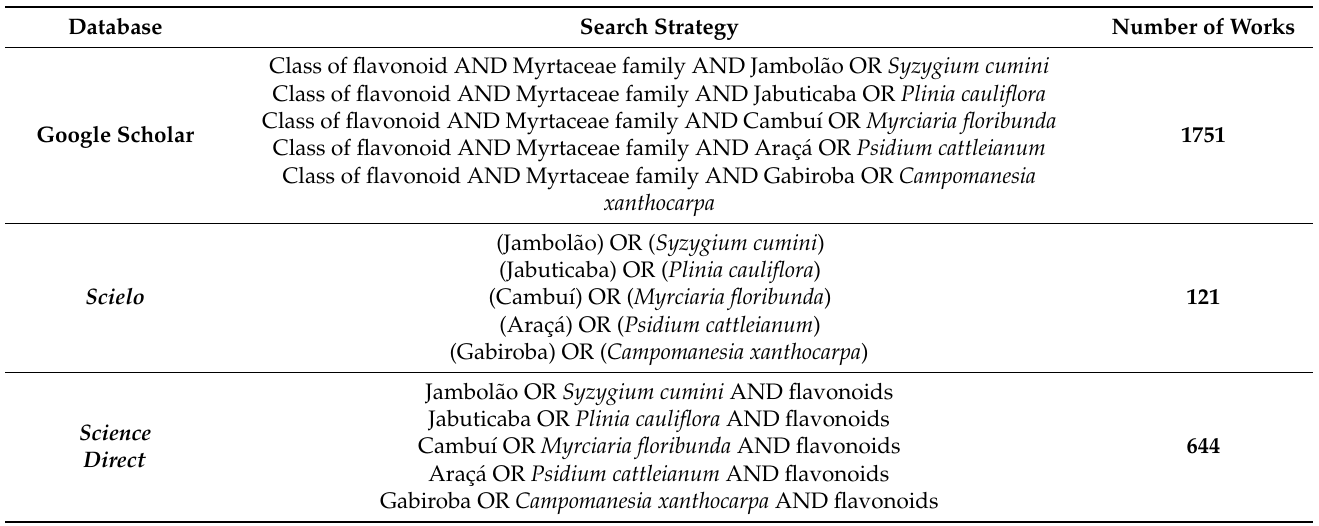
Table 5. Synthesis of selected works with the main flavonoids identified in extracts and their positive health